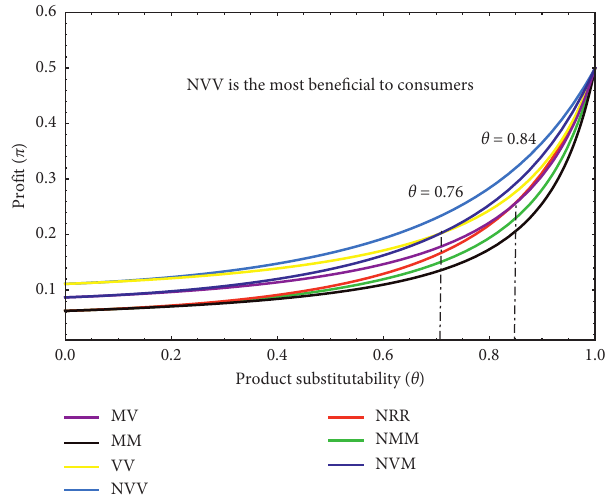
Figure 10: Comparison with respect to consumer welfare among all subgames.